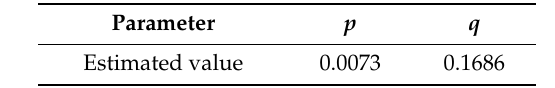
Table 5. Coe ffi cients of innovation and imitation of the Bass